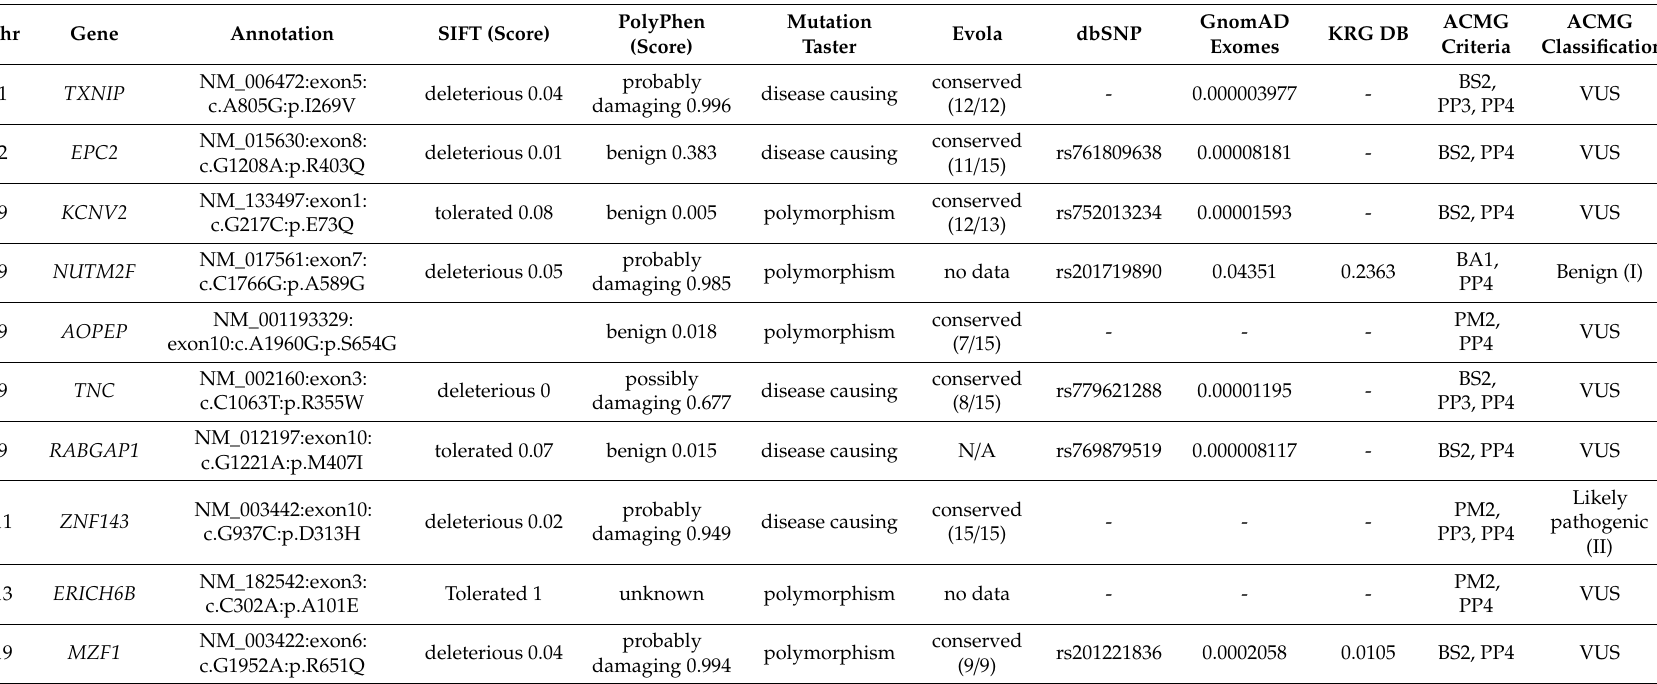
Table 1. Summary of evidence for the pathogenicity classification of candidate rare heterozygous variants identified by whole exome